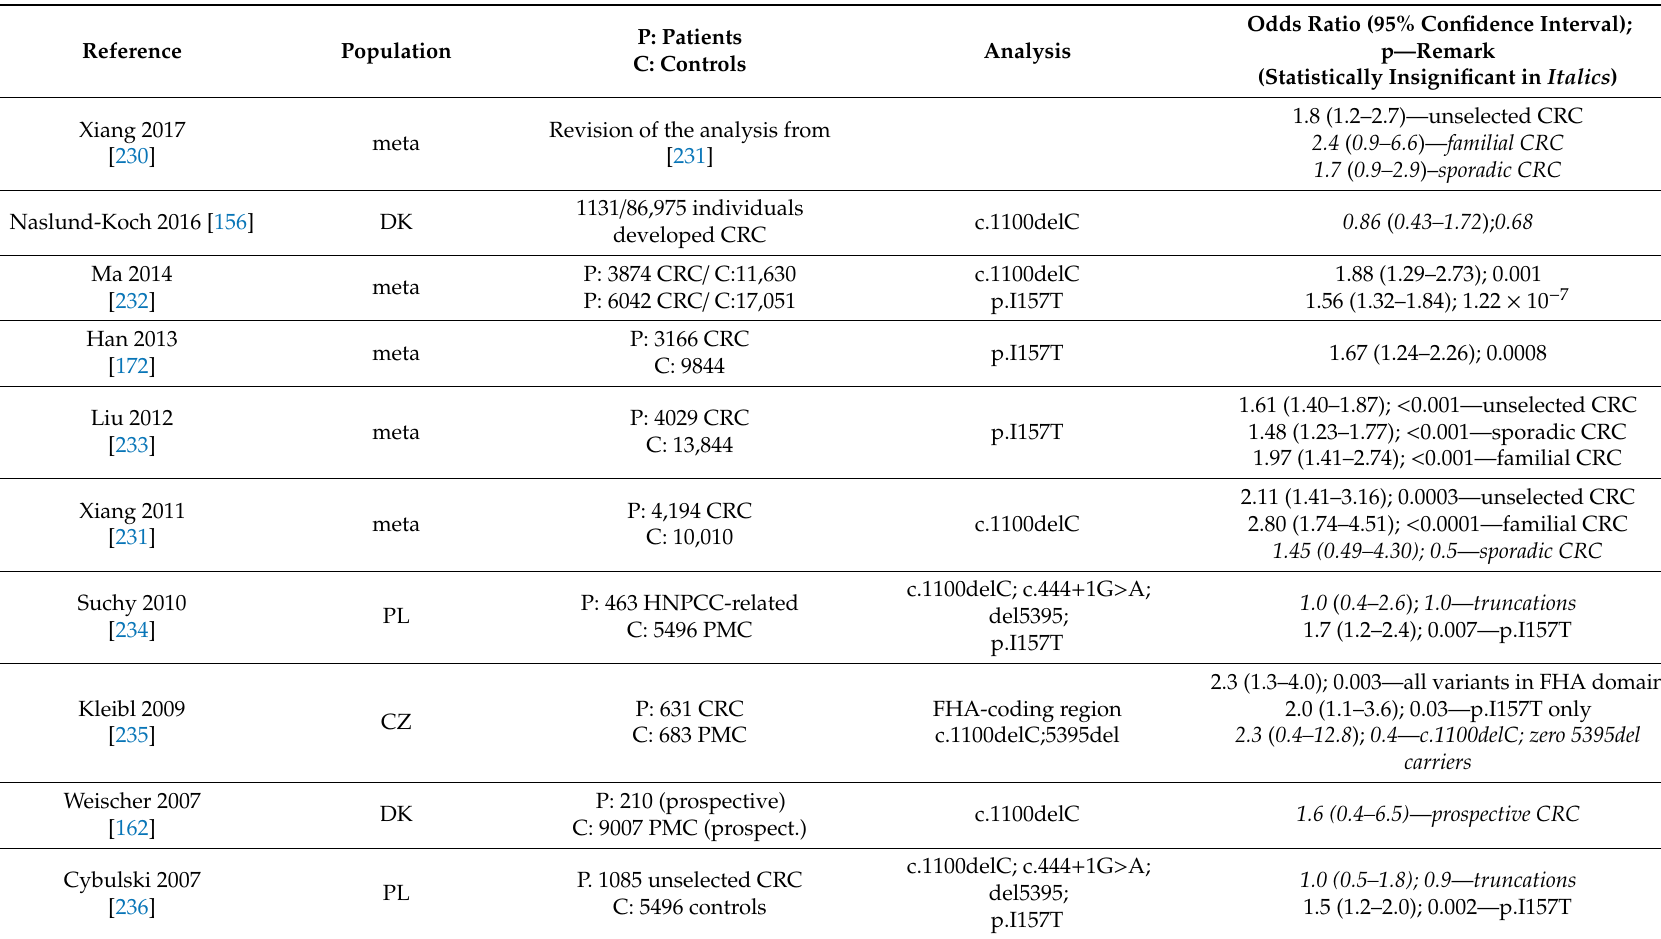
Table 5. Analyses of the entire CHEK2 coding sequence (separately or as a part of panel NGS) or analyses of specific variant(s) in colorectal cancer (CRC)